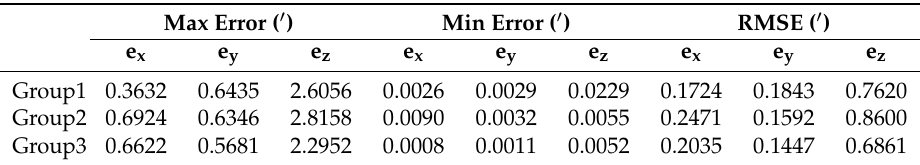
Table 1. Calibration Results.